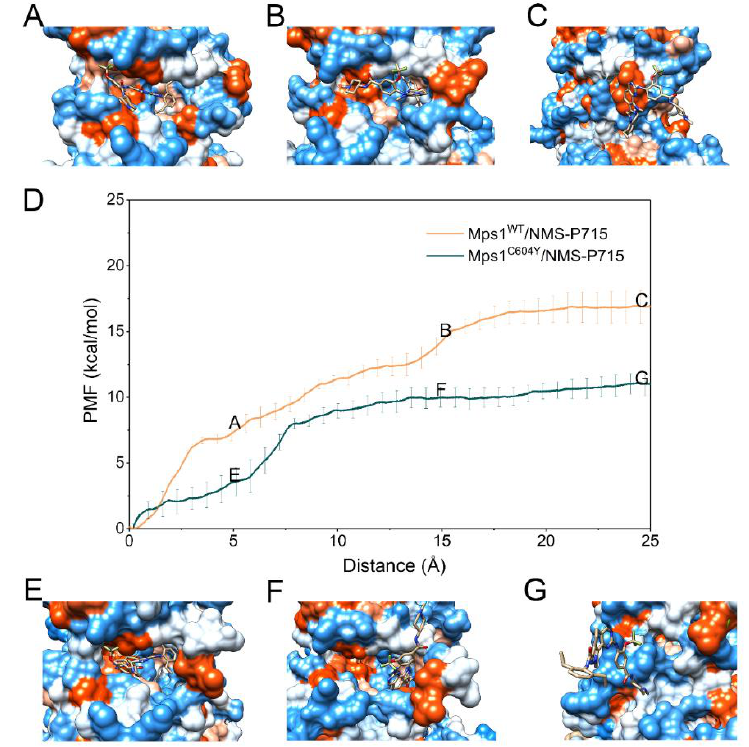
Figure 10. Alignment of the potential of mean forces (PMFs) for NMS-P715 dissociate from Mps1 WT and Mps1 C604Y .